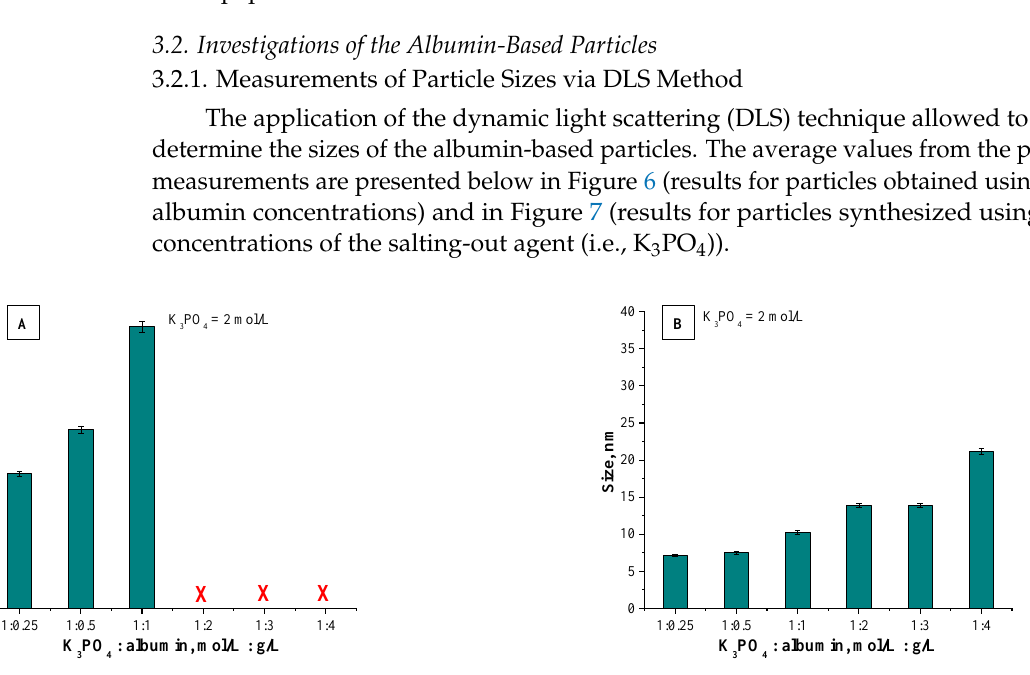
Figure 7. Results of DLS analysis of albumin particles obtained using various K 3 PO 4 concentrations via a syringe system ( A ) and using a burette ( B ) ( n = 3, n —Number of repetitions). Below in Table 3. values of the polydispersity index (PDI) of all prepared samples are listed. Table 3. PDI values of prepared samples. Sample Potassium Phosphate Concentration *: Albumin Concentration RATIO (mol/L: g/L)